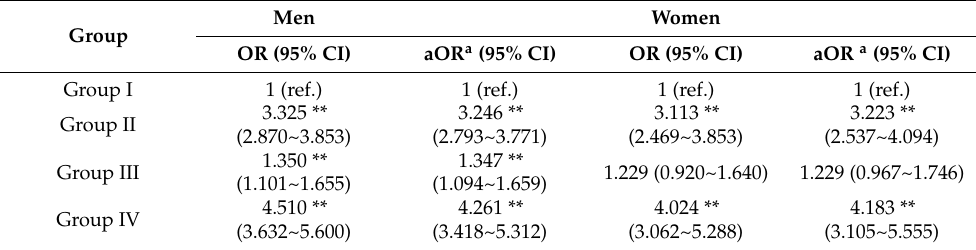
Table 4. The odds of serious irrational procrastination under different combinations of physical activity conditions and mobile phone addiction